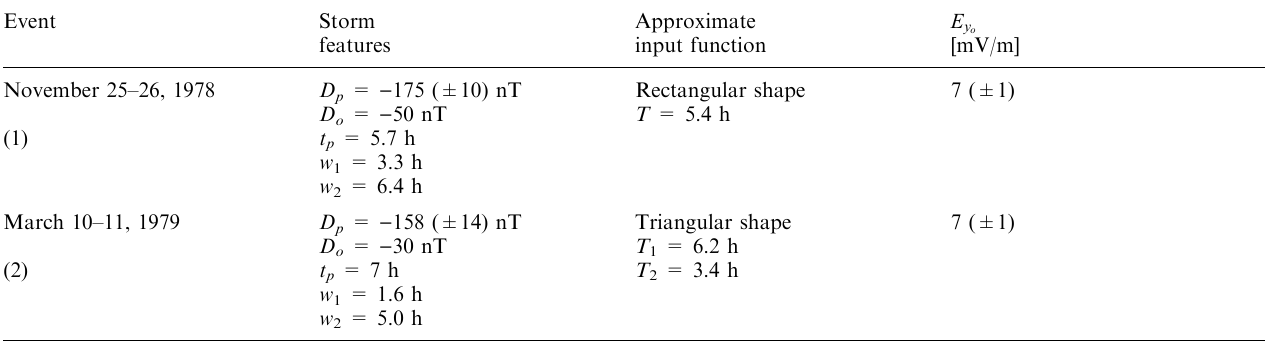
Table 1. Description of the events